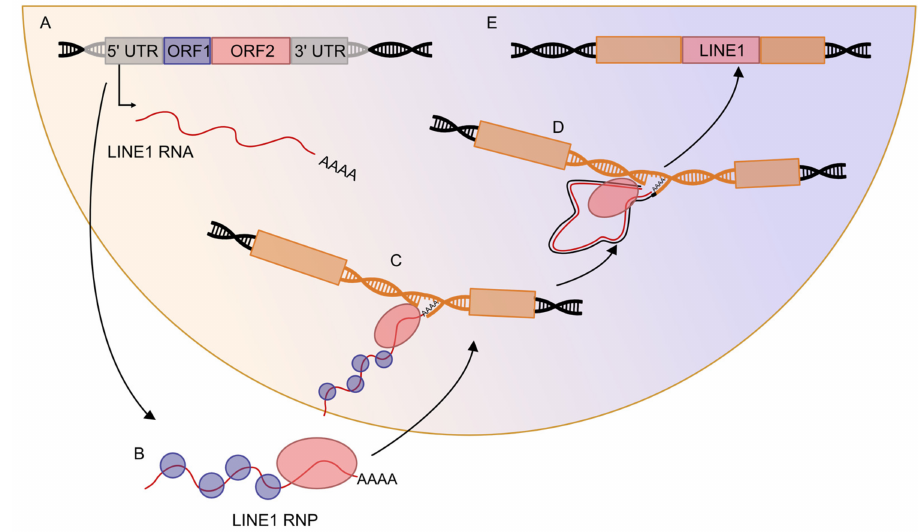
Figure 1. LINE1 retrotransposition mechanism can disrupt gene coding sequence. Mechanism of LINE1 mobilization: ( A ). A full-length retrotransposition competent LINE1 element is transcribed from its promoter and encodes for ORF1 and ORF2 proteins. ( B ). In the cytoplasm, newly translated ORF1 (violet) and ORF2 (pink) bind to their mRNA of origin (red) to form a ribonucleoprotein particle, RNP. ( C ). The RNP complex enters the nucleus after mitosis and targets a novel genomic region bearing the sequence 5 (cid:48) -TTTT/AA-3 (cid:48) , where ORF2 nicks the host DNA. ( D ). ORF2 primes the reverse transcription of LINE1 element. ( E ). The integration of LINE1 can disrupt the coding sequence of a gene, resulting in a dysfunctional